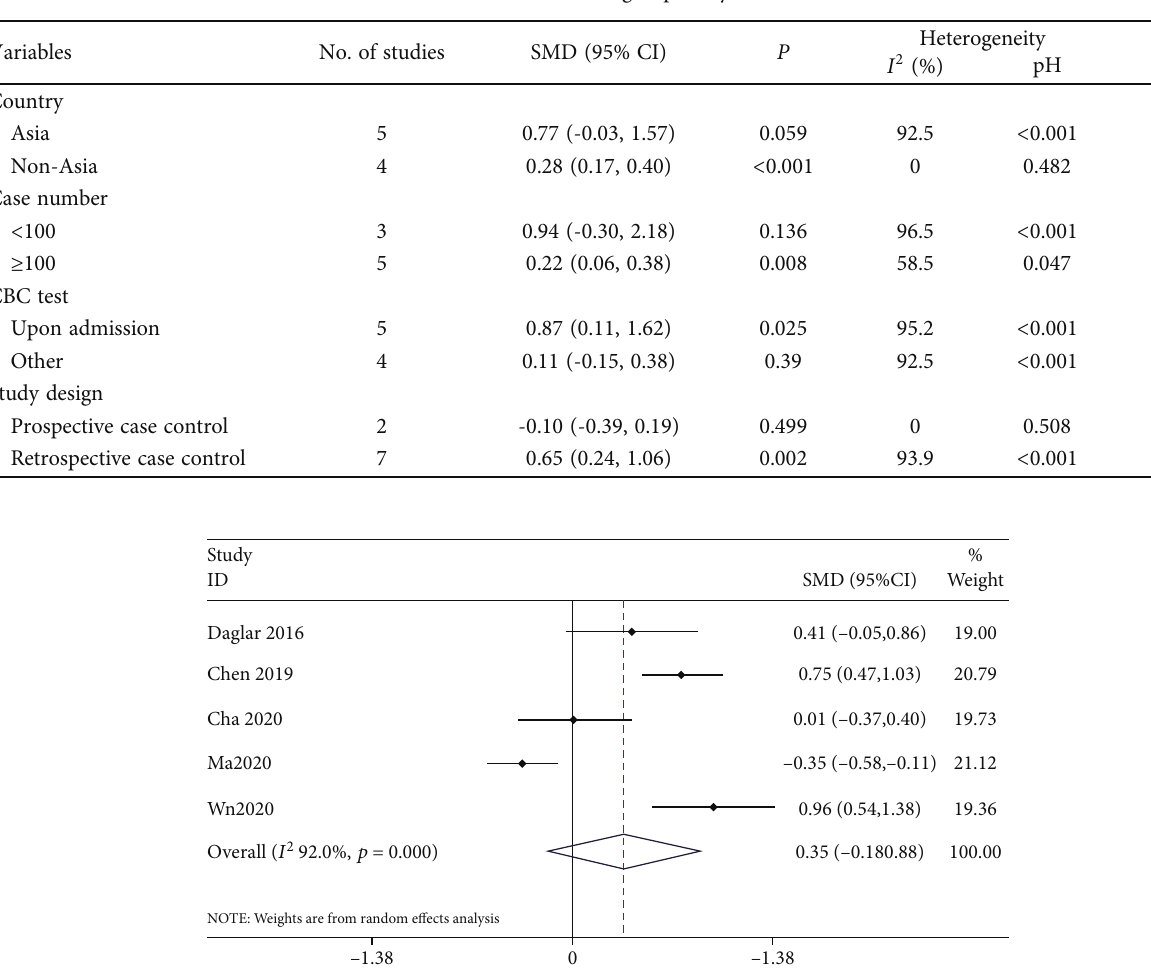
Table 2: PLR subgroup analysis.